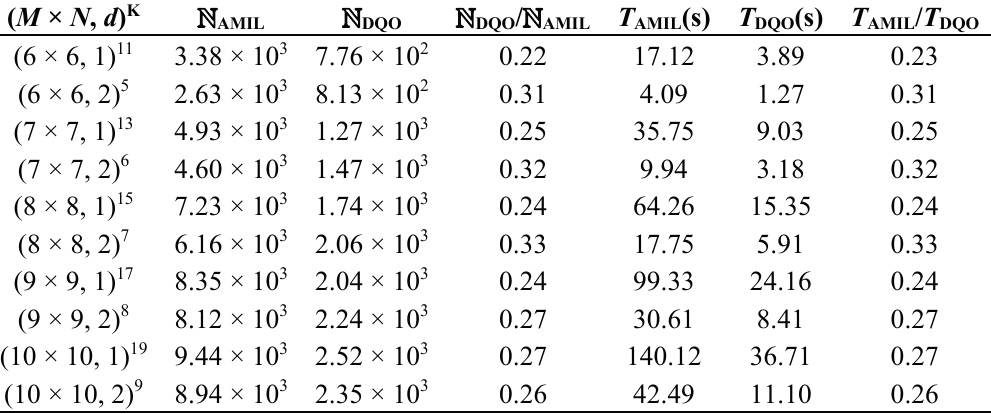
Table 4. Comparison between AMIL and DQO algorithms in ( M × N , d ) K